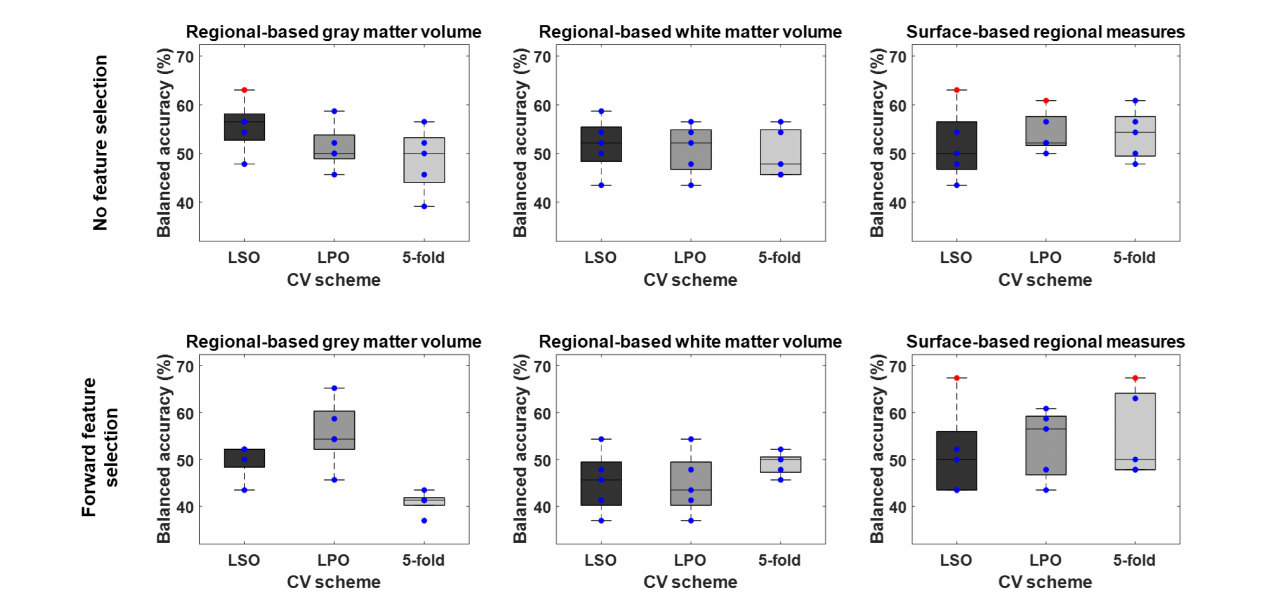
FIGURE3 Balanced accuracy across bootstrapped samples for each tested combination of regional feature type [i.e., regional-based gray and white matter volume; and surface-based regional cortical thickness, gyrification, sulci, and complexity indexes (surface-based regional measures)], feature selection [i.e., no feature selection; and forward feature selection (FFS)], and cross-validation (CV) scheme [i.e., leave-one scan acquisition protocol-out (LSO) CV; leave-one per group-out (LPO) CV; and 5-fold CV]. Dots represent the balanced accuracy value in each of the five bootstrapped samples and are red colored if the balanced accuracy is statistically significant (i.e., p < 0.05) or blue colored if it is not (i.e., p > 0.05). The statistical significance of the balanced accuracy in each bootstrapped sample was evaluated through permutation